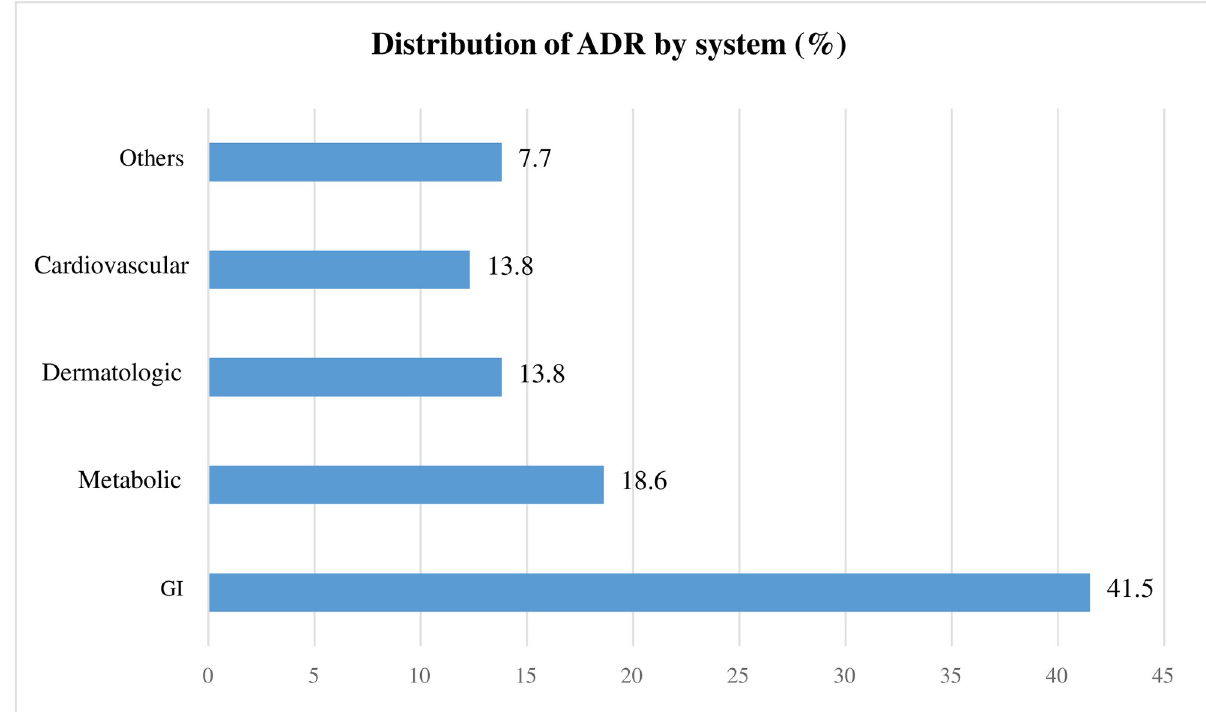
Fig 2. Patterns of ADR respect to the affected systems among hospitalized patients in the UoGCSH medical ward from May 28 up to July 26, 2022 (N = 65). Other, Nerve system, urinary system; GI, Gastrointestinal.